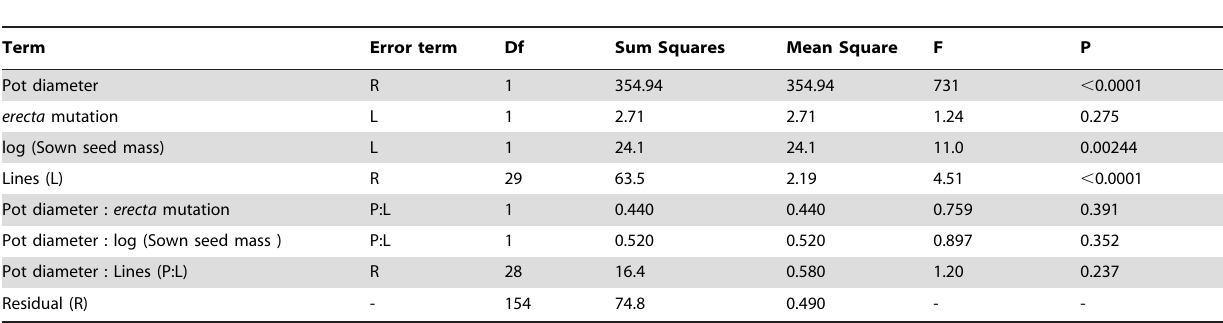
Table 6. ANOVA of harvested seed number with sown seed mass fitted as the explanatory variable.